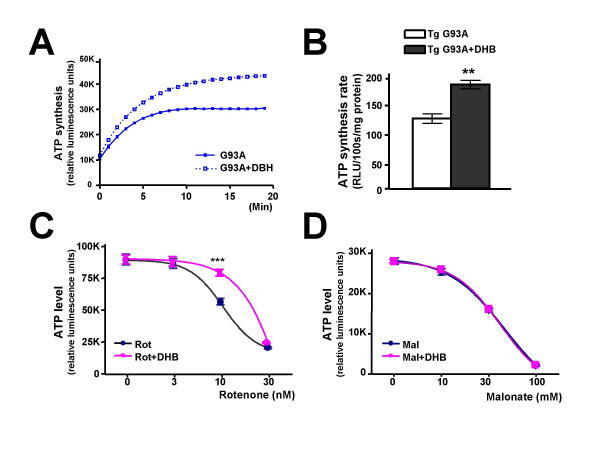
Differential effect of DHB on mitochondrial activity. (A) Representative examples of ATP synthesis measurements in spinal cord expressed as relative luminescence units (R.L.U.). (B) The rate of ATP synthesis in SOD1-G93A mitochondria purified from spinal cord (data = mean ± se; repeated measures, n = 9; ** - p < 0.001). (C) Effect of DHB on rotenone mediated cell viability. Primary mixed spinal cord neurons from SOD1-G93A mice were cultured in the presence or absence of DHB (5 mM) and exposed to mitochondrial Complex I inhibitor rotenone (data = mean ± se; Rot: n = 4, Rot+DHB: n = 4; *** - p < 0.001, Rot vs. Rot+DHB). (D) Absence of specific inhibition of DHB in SOD1-G93A cultures exposed to mitochondrial Complex II inhibitor malonate (data = mean ± se; Mal: n = 4, Mal+DHB: n = 4).